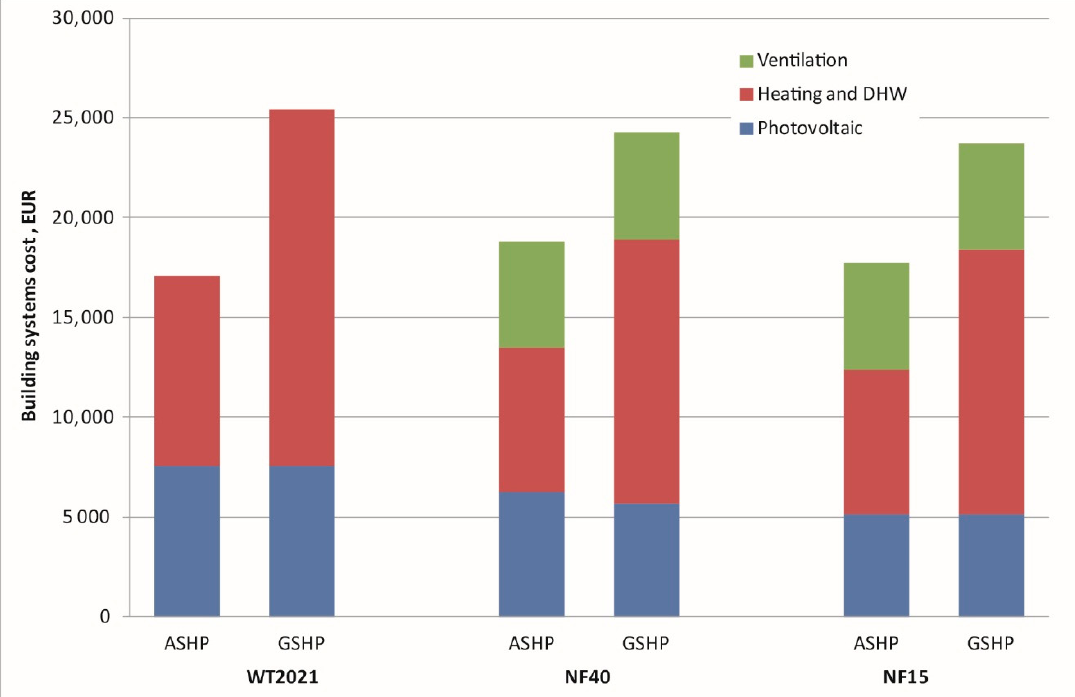
Figure 4. The building systems cost for all the variants.